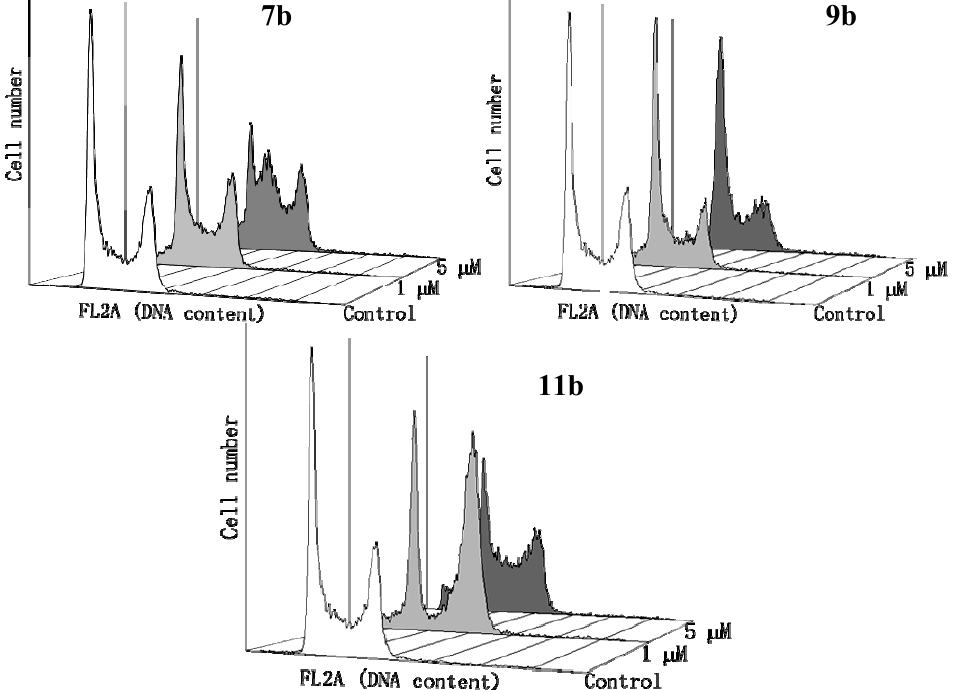
Figure 5. Effects of compounds on cell cycle distribution of HCT-116